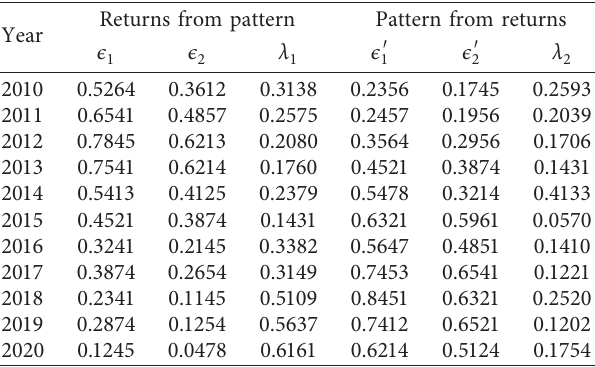
Table 8: Prediction error reduction index of Index BANK-NIFTY for the period 2010–2020.